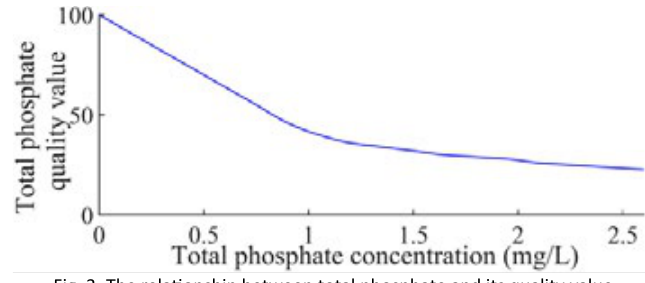
Fig. 2: The relationship between total phosphate and its quality value Fig. 3: The relationship between total phosphate and its quality